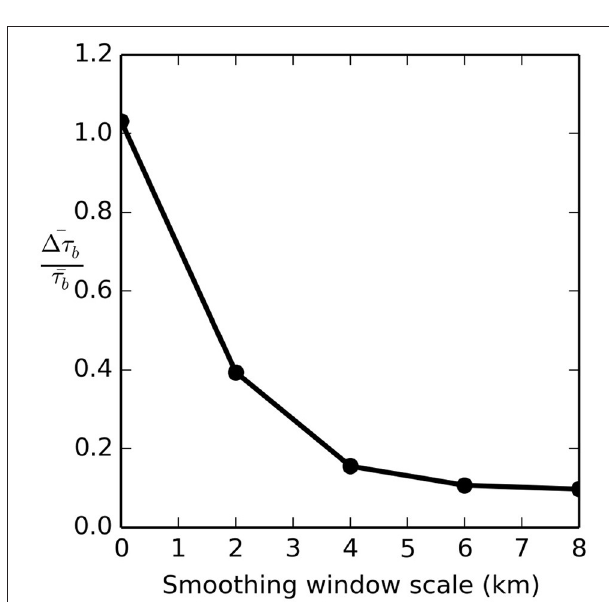
FIGURE 6 | Mean basal drag uncertainty over the study domain ( △ τ b ) displayed as a fraction of the mean computed basal drag ( τ b ) for different smoothing window